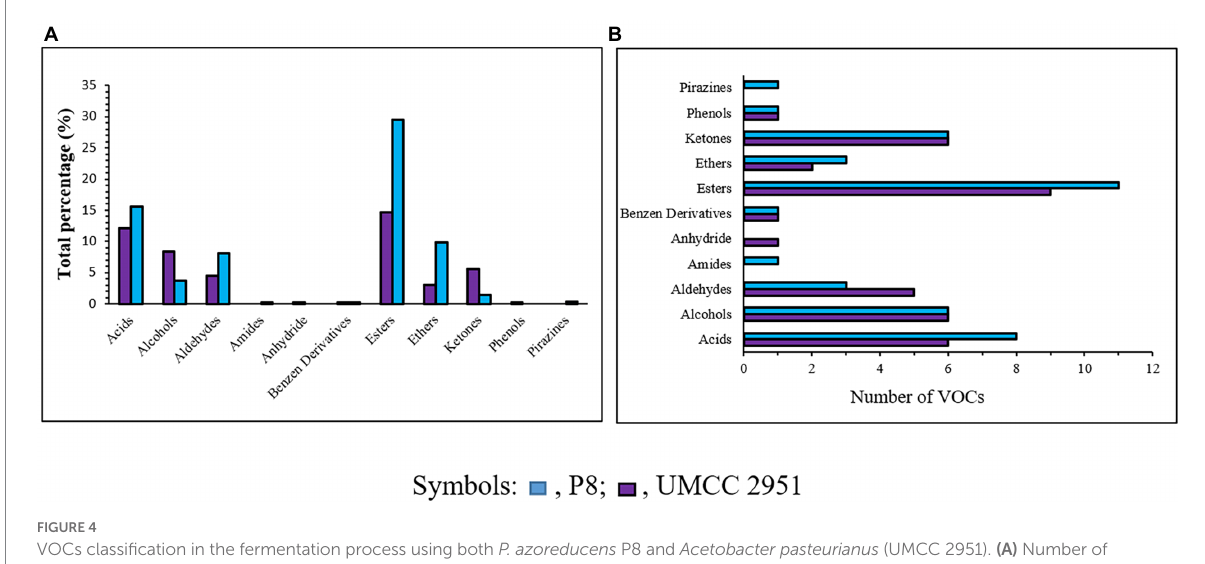
FIGURE 4 VOCs classification in the fermentation process using both P. azoreducens P8 and Acetobacter pasteurianus (UMCC 2951). (A) Number of compounds grouped in chemical families. (B) Total percentages for each chemical family